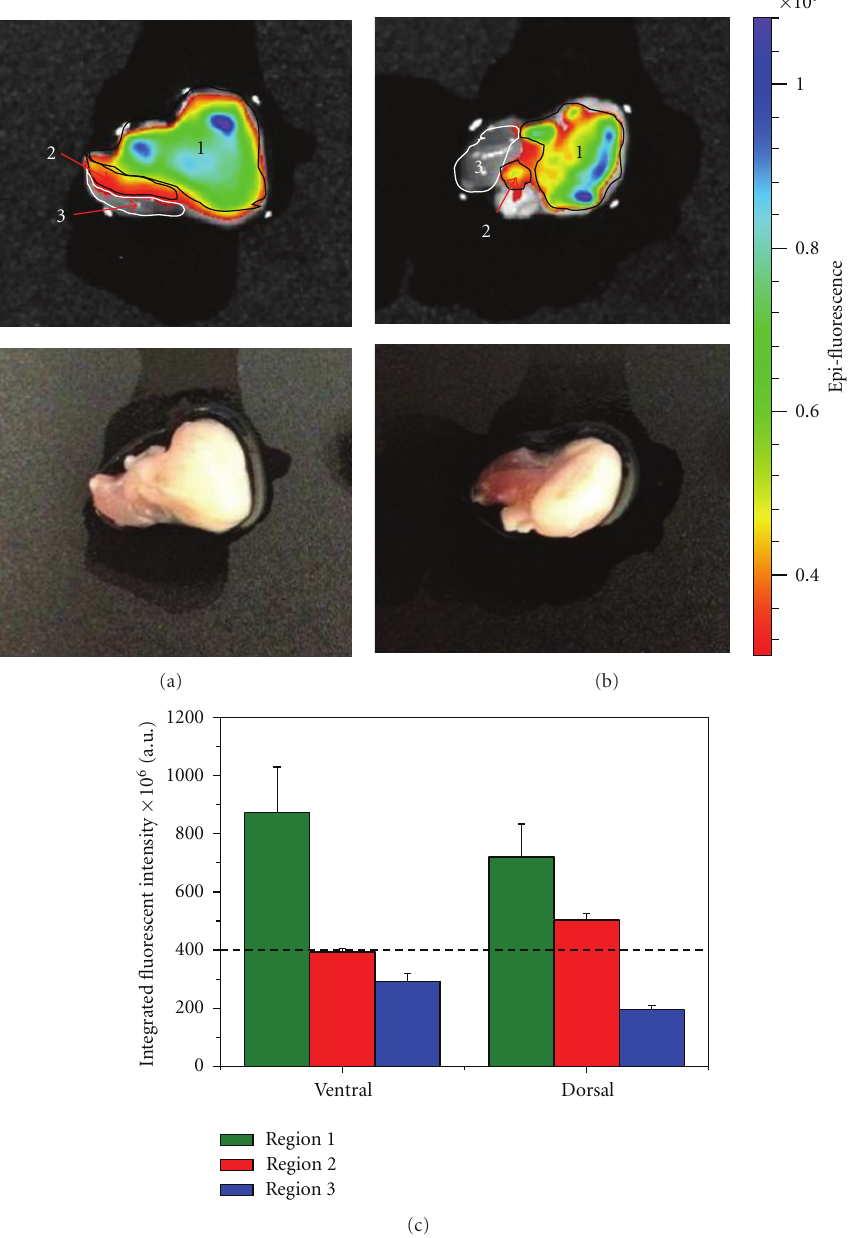
Figure 5: Animal tumor imaging. Top panel: fluorescent imaging using IVIS system. Bottom panel: bright field images of the same tumor. Two orientations of the tumor were imaged: (a) ventral side; (b) dorsal side. (c) The integrated fluorescent intensity was quantified using IVIS software for 3 regions of the tumor. Dash-line indicates the cut-o ff between normal and cancer